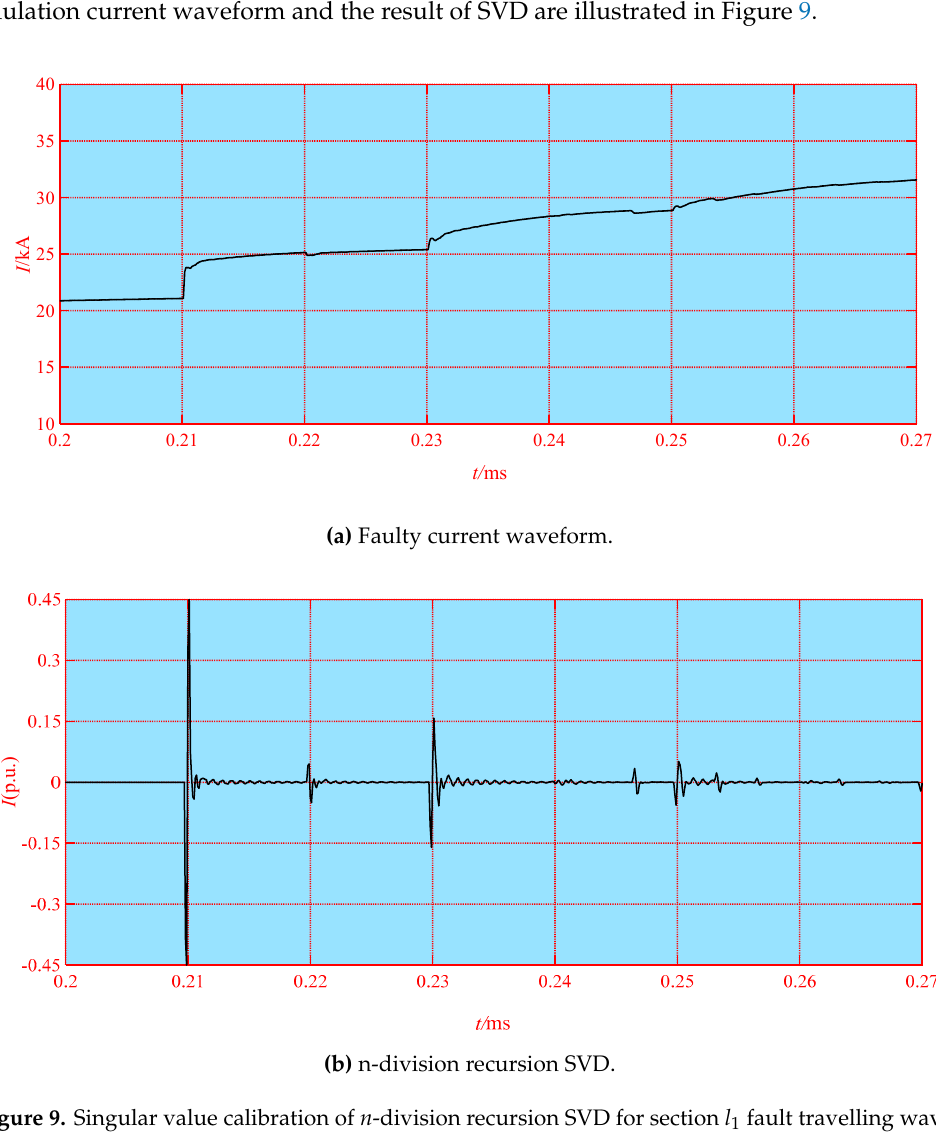
Figure 9. Singular value calibration of n -division recursion SVD for section l 1 fault travelling wave.